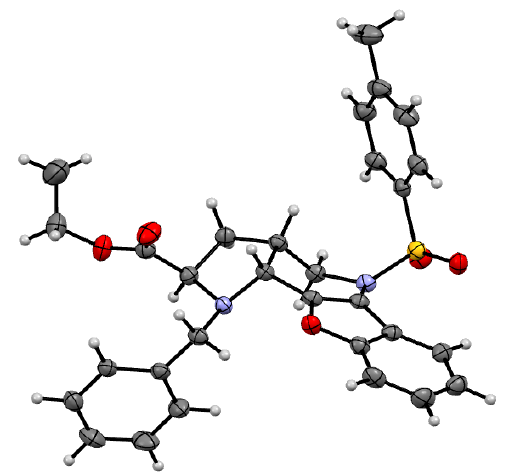
Figure 1. ORTEP diagram of molecule 9Ac .